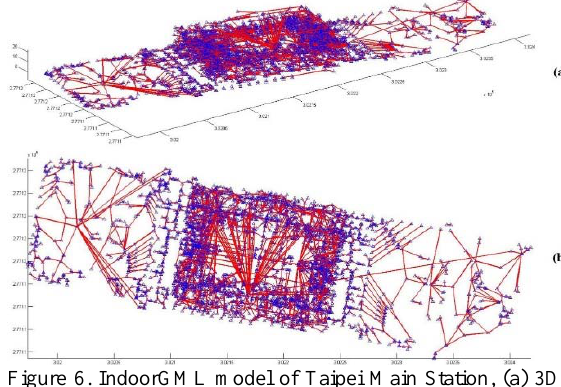
Figure 6. IndoorGML model of Taipei Main Station, (a) 3D model, (b) plan